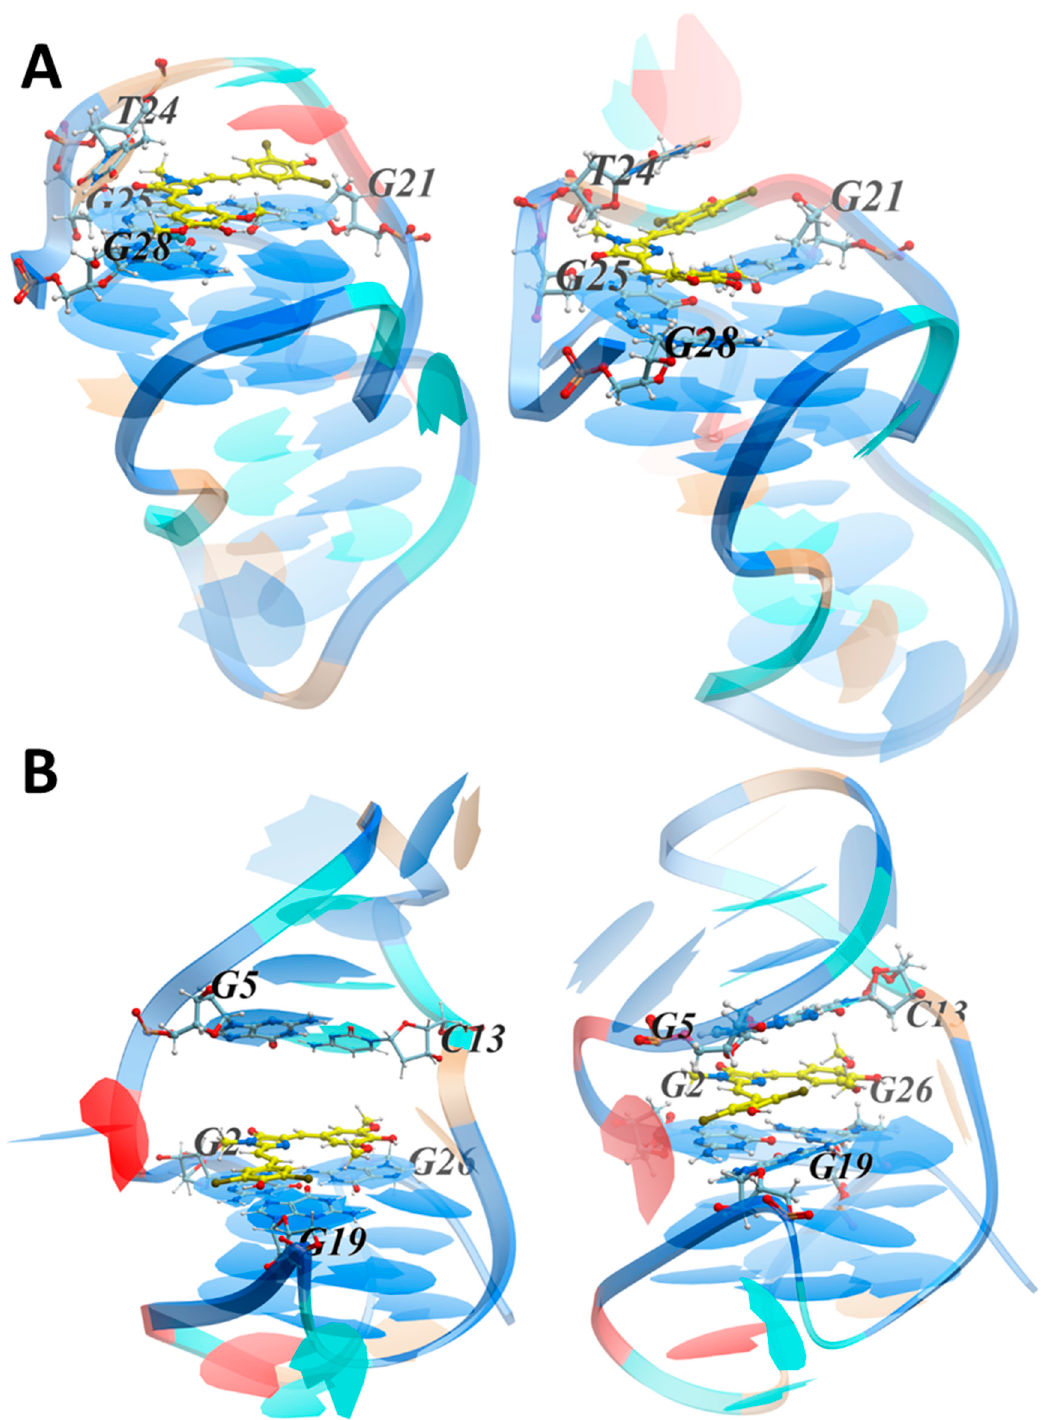
Figure 6. The conformations of the complexes with ZS260.1 on the outer G tetrad ( A , complex 1) and within the cavity ( B , complex 2) of the LTR-III structure at the initial, 0 ns ( left ) and final, 80 ns ( right ) stages of MD simulations. The DNA shown by rendering with the nucleotides are colored as follows: G, blue; A, red; T, light brown; C, cyan. Cavity-forming nucleotides and ligand are in ball-and-stick representation. Atoms are represented by the following colors: ligand carbon, yellow; DNA carbon, ice blue; oxygen, red; nitrogen, blue; and hydrogen, white. In complex 2 (the ligand is located in the cavity near 5 ′ -terminus), the interactions were more efficient due to the van der Waals contribution resulting from the large number of nucleotides involved in stacking interactions with the ligand (Figure S11-1). The